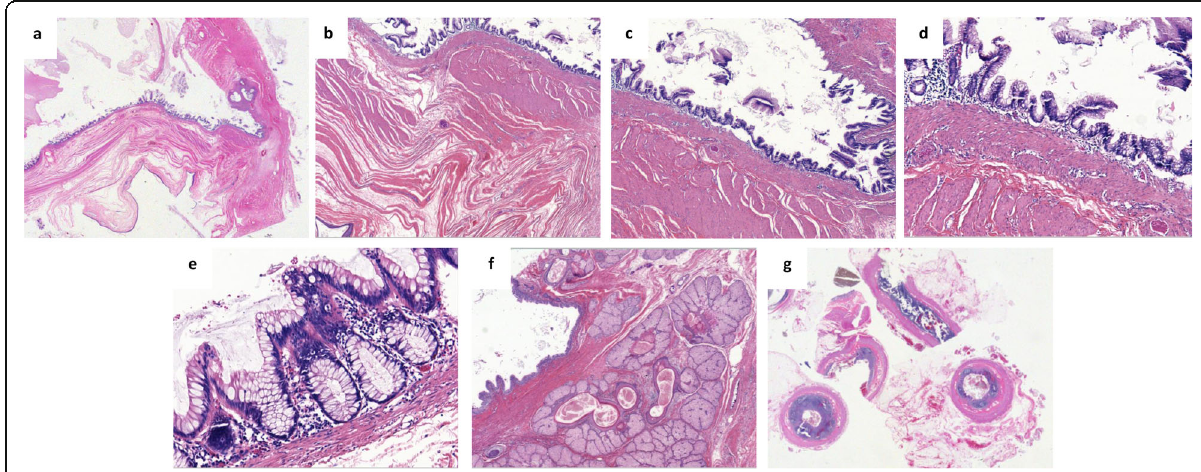
Fig. 1 Histological aspects of the ovarian teratoma (a-f) and the normal appendix (g). Views of the organoid colonic/appendiceal wall inside the ovarian teratoma at the top, composed of mucosa, muscularis mucosae, submucosa and muscularis propria, with dissociated mucus at left, close to some squamous teratomatous element at the bottom, without any magnification (a) and with low-power magnification Gx25 (b). Focus on colonic/appendiceal LAMN comprising elongated glands layered by mild atypical proliferating cells producing mucin at magnification Gx50 (c), Gx100 (d) and Gx200 (e). View of other teratomatous elements, mostly of cutaneous epithelium and glands at magnification Gx50 (f), and of the histologically normal appendix without magnification